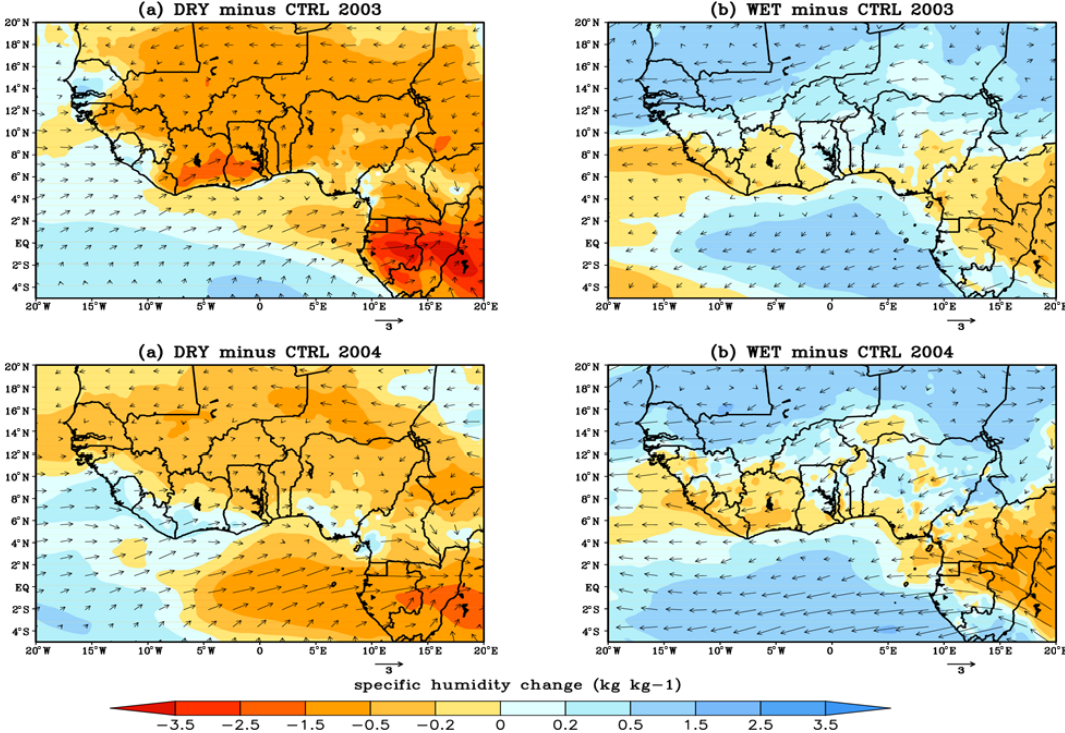
Figure 10. The lower-tropospheric wind (850hPa) and moisture bias for JJAS 2003 and JJAS 2004 from the dry (a, c) and wet (b, d) experiments with respect to the control experiment.